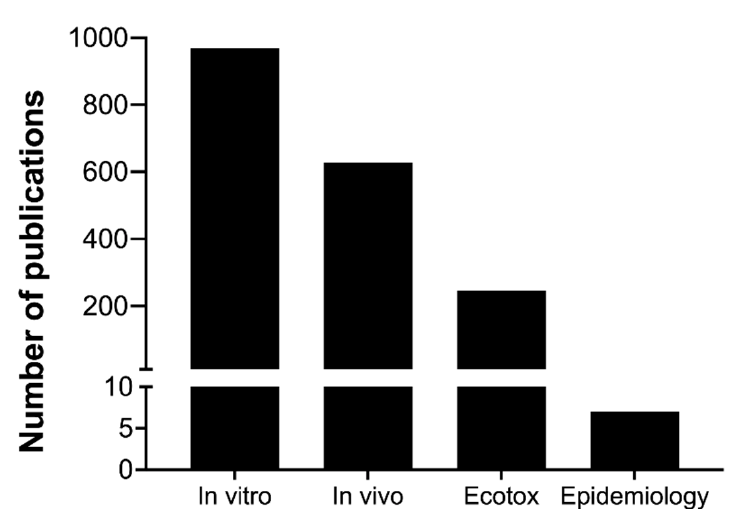
Figure 5. Nanomaterial-induced genotoxicity in various model systems (the figure is generated with the numbers of published papers appearing in PubMed database with specific keyword search; epidemiology mainly represents “occupational exposure”-related studies; ecotoxicology model species include mainly fish species, drosophila, bivalve mollusks, C. elegans , white worms, yeast, etc.). It is noteworthy that most focus has been given to DNA damage (strand break